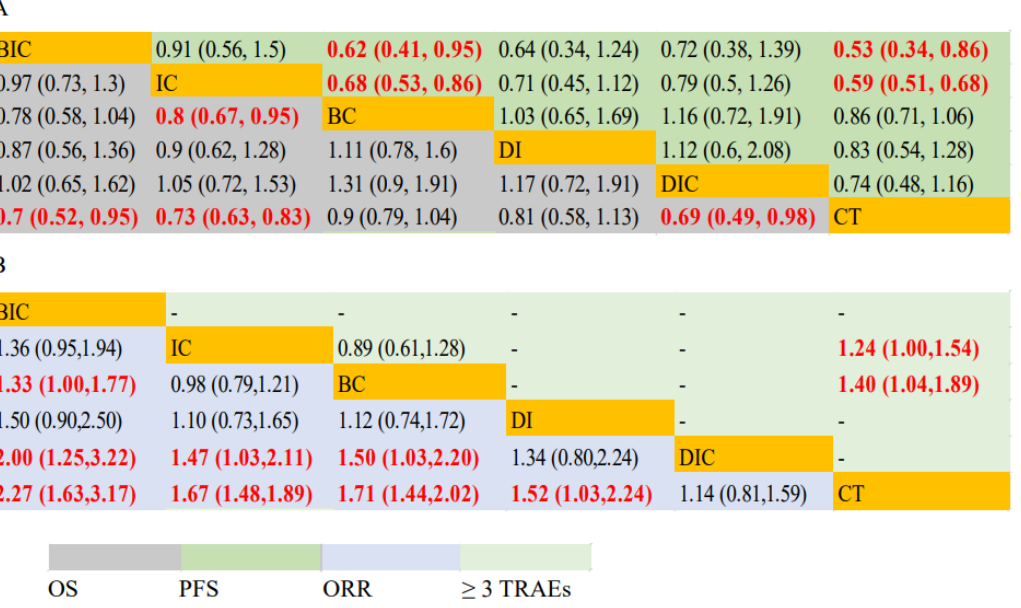
Figure 3. ORR, PFS, OS and safety profiles in the whole cohort analysis according to network meta-analysis. Each cell contains the pooled HR and 95% CI for PFS and OS ( A ) and RR and 95% CI for ORR and ≥ 3 TRAEs ( B ); significant results are indicated in red.